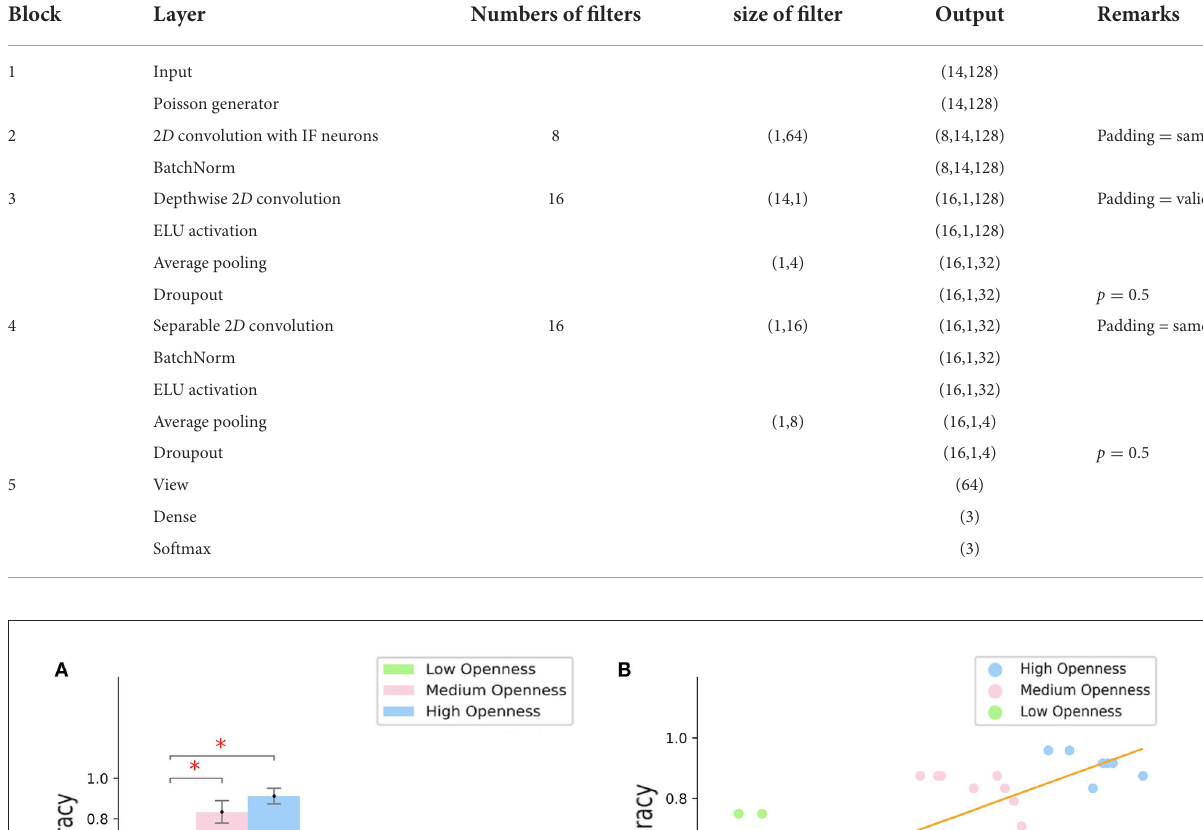
TABLE 1 Spike-EEGNet architecture.